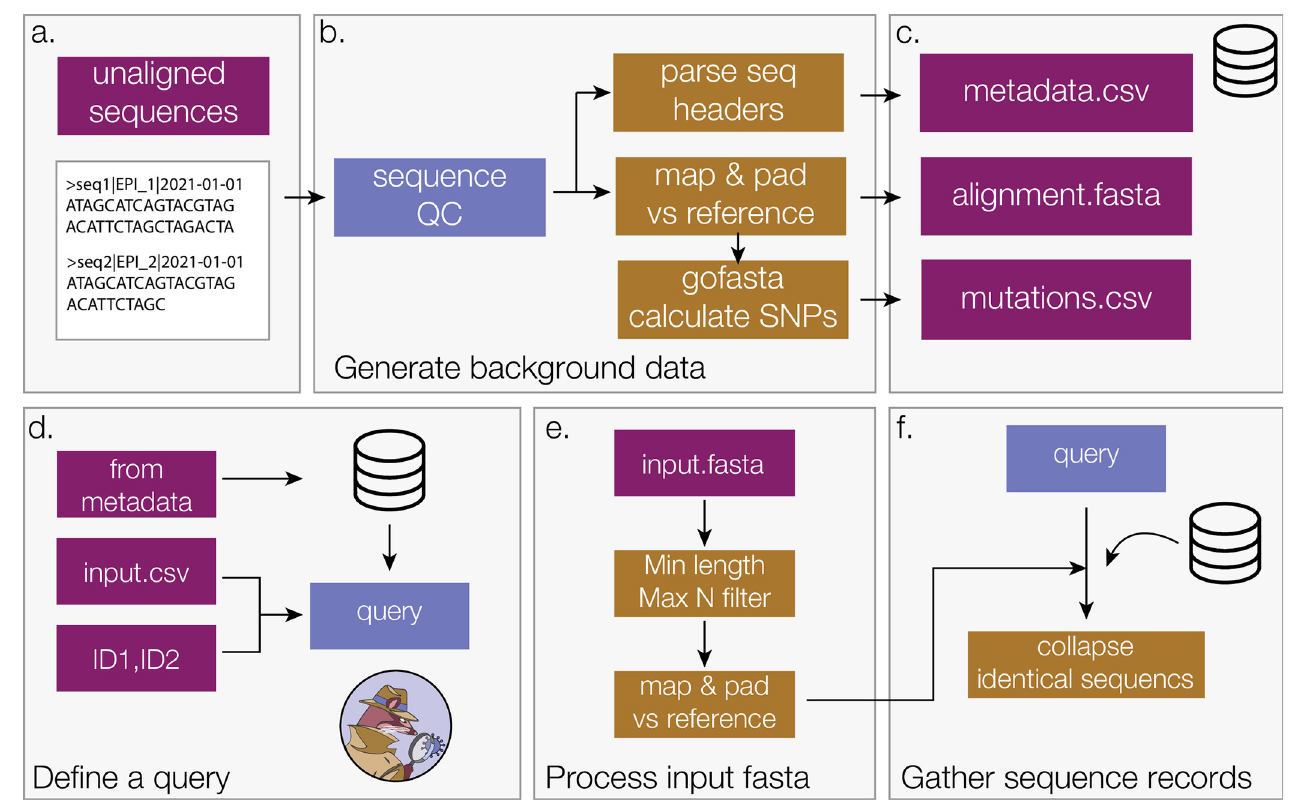
Fig 1. Background data generation pipeline (a-c) and how a civet query is defined (d-f). In order to contextualize the query sequences, civet requires a set of background data files, minimally an alignment and metadata file. a) These files can be generated from an unaligned multi-sequence file using the flag:— generate-background-data parse_seq_headers. Alternatively, the latest downsampled Augur download hosted on GISAID can be converted into civet background data using the flag:—generate-background-data align_curate. b) The genome sequences are put through a minimum length and maximum N- content filter before being mapped against a reference sequence. The alignment file is generated by trimming the genome sequences to the protein coding region (positions 265 to 29674) defined by the SARS-CoV-2 reference genome (Genbank ID: NC_045512.2), masking the untranslated regions (UTRs) with Ns. The SARS-CoV-2 reference genome and coordinates are used by default, however this can be configured for a different genome and different coordinates. Information encoded in the sequence header is used to generate the metadata file. gofasta condenses the alignment to the set of derived nucleotide changes in each sequence with respect to the root of the pandemic, to provide an extra speed up for analysis within civet. c) The background files created can then be used as the background data for civet with—datadir or set as an environment variable. d) The query is generated from the background data supplied by specifying a set of criteria to match against, for example all sequences from a particular location within a certain timeframe. The user can also provide a string of specific ids to match or an additional metadata file that specifies the query records and may contain extra metadata fields that only correspond to query sequences, for example patient IDs. e) An additional fasta file for sequences not present in the background data can be provided and civet will perform some quality control checks and align the sequences by mapping and padding against the reference (Default NC_045512.2). f) civet combines the set of query sequence records matched from the background data and from the input fasta file to generate the full query set, and then collapses identical sequences for efficiency. These get expanded out at the end of the analysis